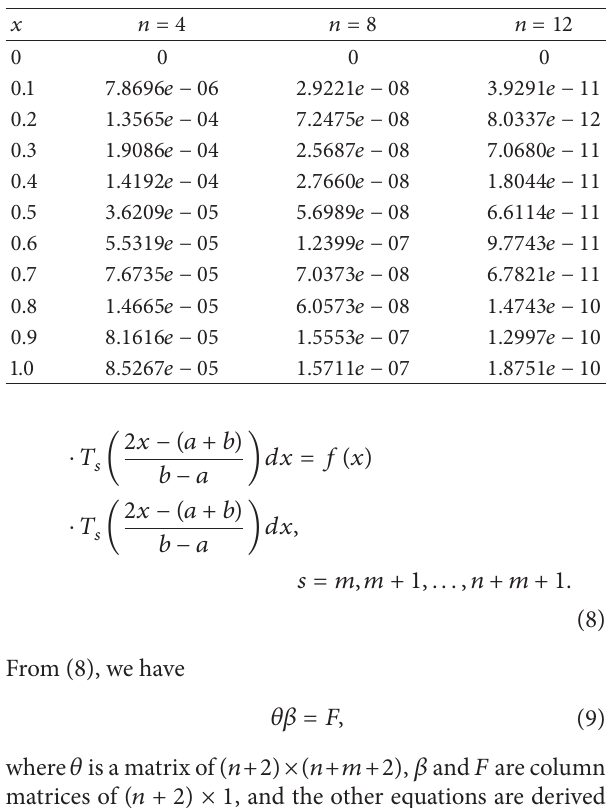
Table 1: Absolute errors for Example 1 at different 𝑛